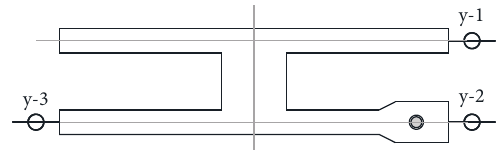
Figure 8: Layout of displacement meters.